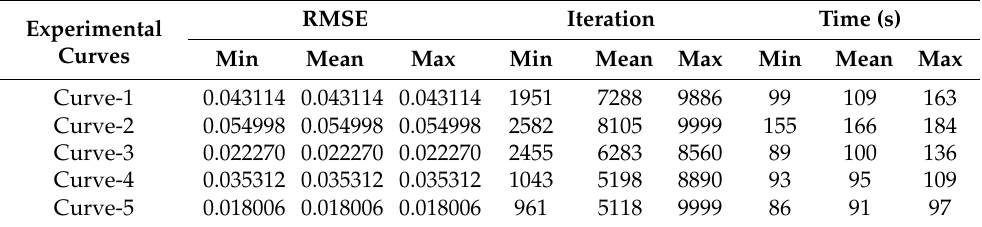
Table 11. JKM330P-72 DDM PV module statistical results for all respective curves.